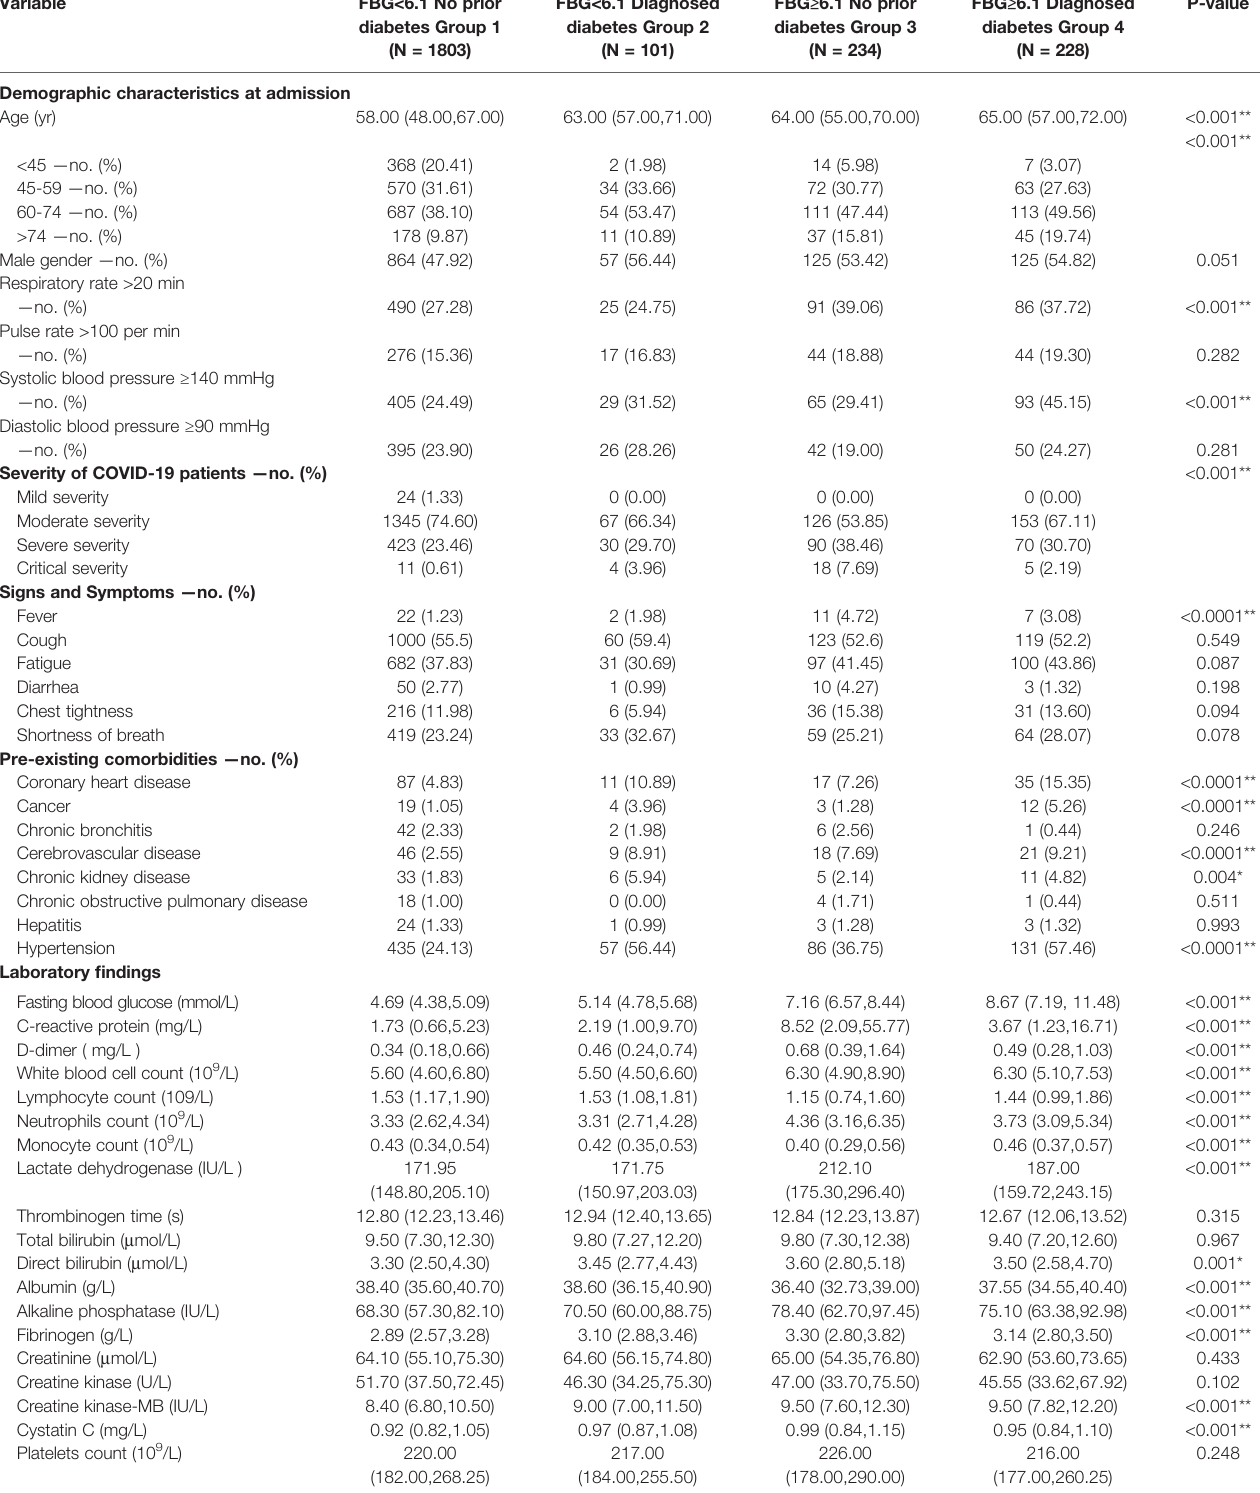
TABLE 1 | Basic demographic characteristics, signs and symptoms, comorbidities, laboratory fi ndings, treatment and clinical outcomes of patient groups in COVID-19. (Unit of FBG is mmol/L).